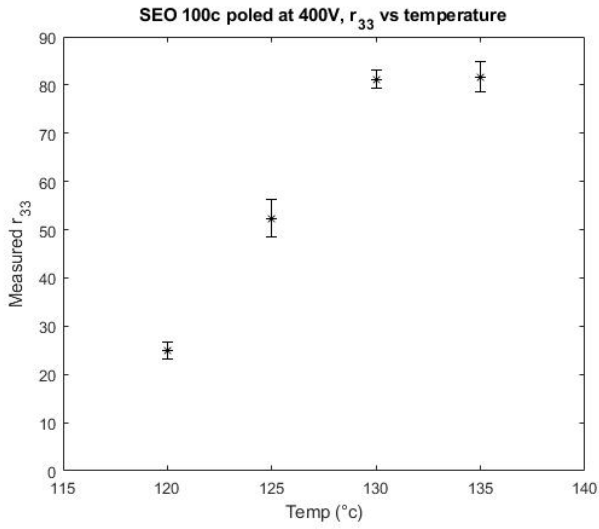
Figure 7. An increased r 33 for SEO100c is seen as the maximum poling temperature is increased.